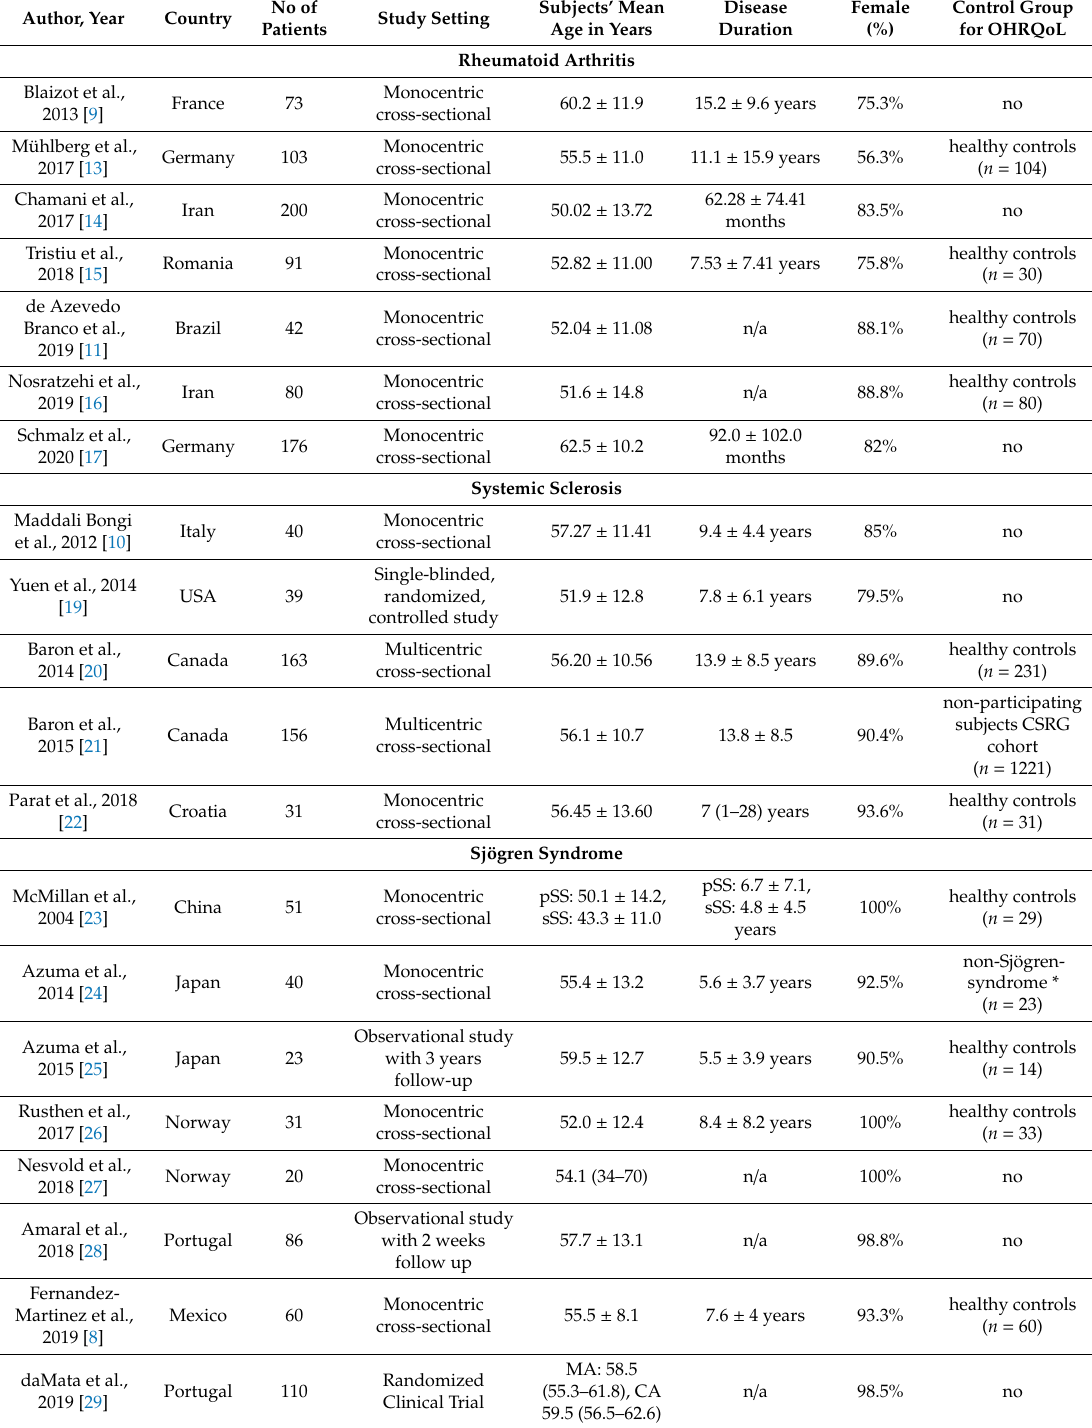
Table 1. Studies included in systematic review. Values for age and disease duration are presented as mean value ± standard deviation or mean value